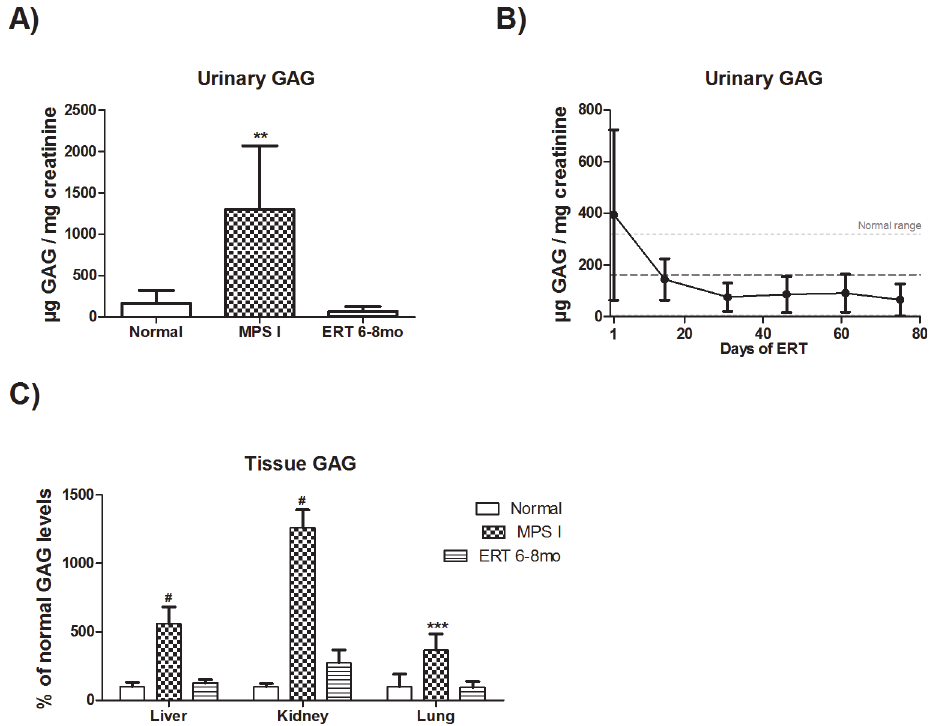
Fig 1. Urinary and tissue GAG levels. A) MPS I mice treated from 6 to 8 months with 1.2mg laronidase/kg every two weeks (n = 10). Urine was collected 1 day post injections. ** P < 0.01, ANOVA and Tukey. B) Comparison between urinary GAG from 8-month old wild-type (normal, n = 4), MPS I (n = 3) and treated MPS I mice (ERT 6 – 8mo, n = 10), 1 day after last injection. Treated mice achieve normal GAG level (dotted lines) as soon as the second injection. C) Tissue GAG from 8-month old normal (n = 4/5), MPS I (n = 5 – 6) and ERT 6 – 8mo (n = 10) mice collected two weeks after last injection. #P < 0.05, Kruskal-Wallis and Mann-Whitney post hoc . *** P < 0.001 ANOVA and Tukey post hoc